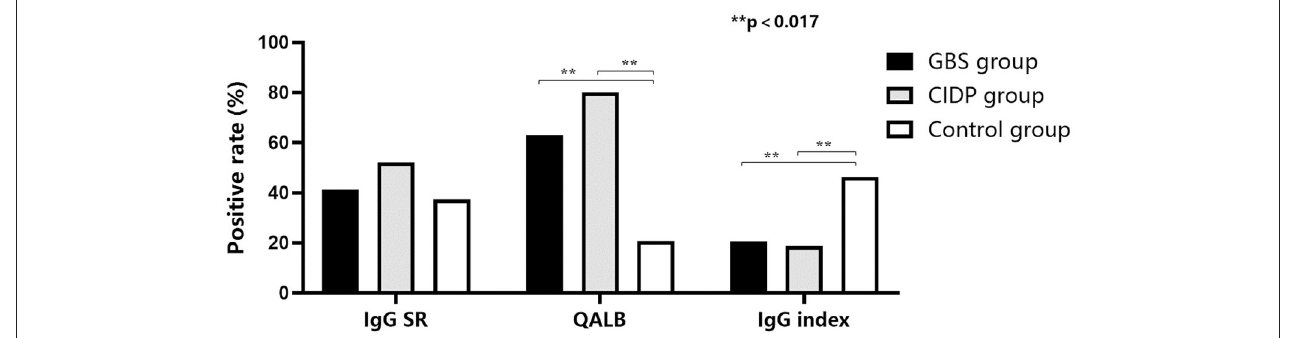
FIGURE 1 | Comparison of the positive IgG SR, QALB and IgG index rates in the GBS, CIDP and control groups. The positive QALB rate in the GBS and CIDP groups was significantly higher than that in the control group ( P < 0.017). The positive IgG index rate in the GBS and CIDP groups was significantly lower than that in the control group ( P < 0.017).